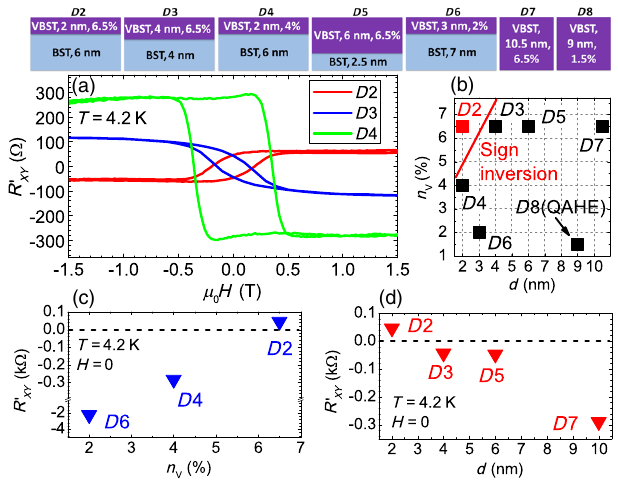
FIG. 4. (a) Magnetic field dependence of the offset corrected Hall resistance ( R 0 xy ) for devices D 2 – D 4 . (b) Magnetic doping per thickness phase space with position of the devices D 2 – D 8 , including the position where the quantum anomalous Hall effect was observed in this material system (device D 8 , see Supple- mental Material [32]). (c),(d) Offset corrected zero field value of the Hall resistance as a function of magnetic doping level (c) and magnetic layer thickness (d) for the positively magnetized state. A schematic layer layout for devices D 2 – D 8 is presented at the top of the